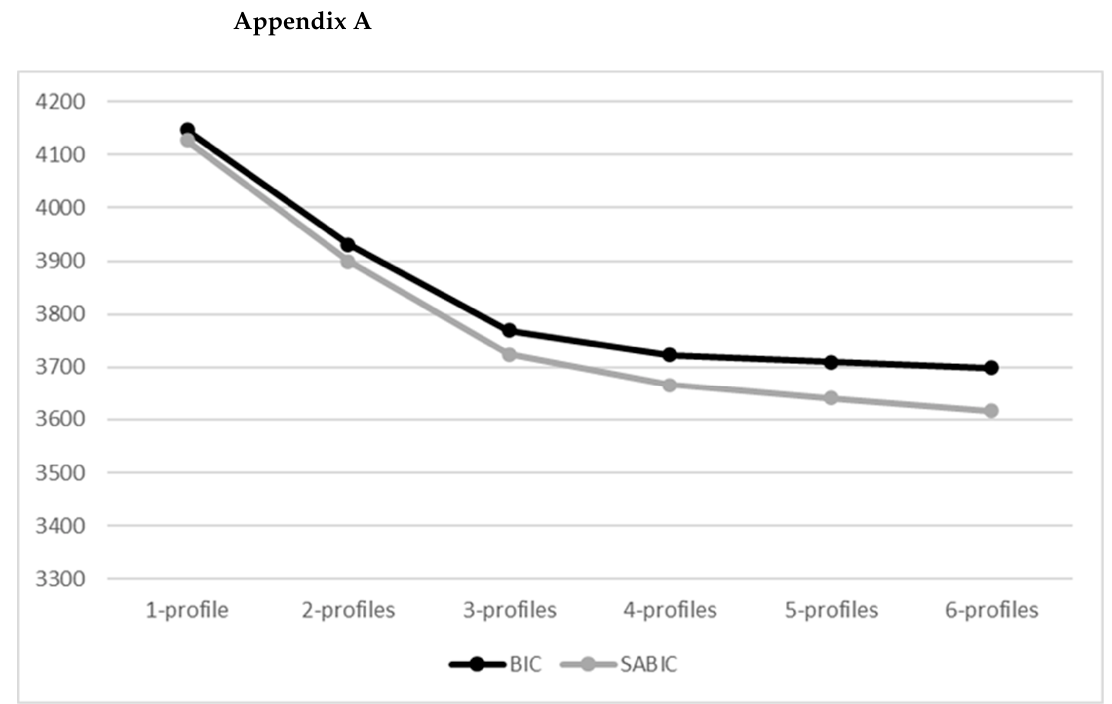
Figure A1. BIC and SABIC plots based on Time 1 LPA.